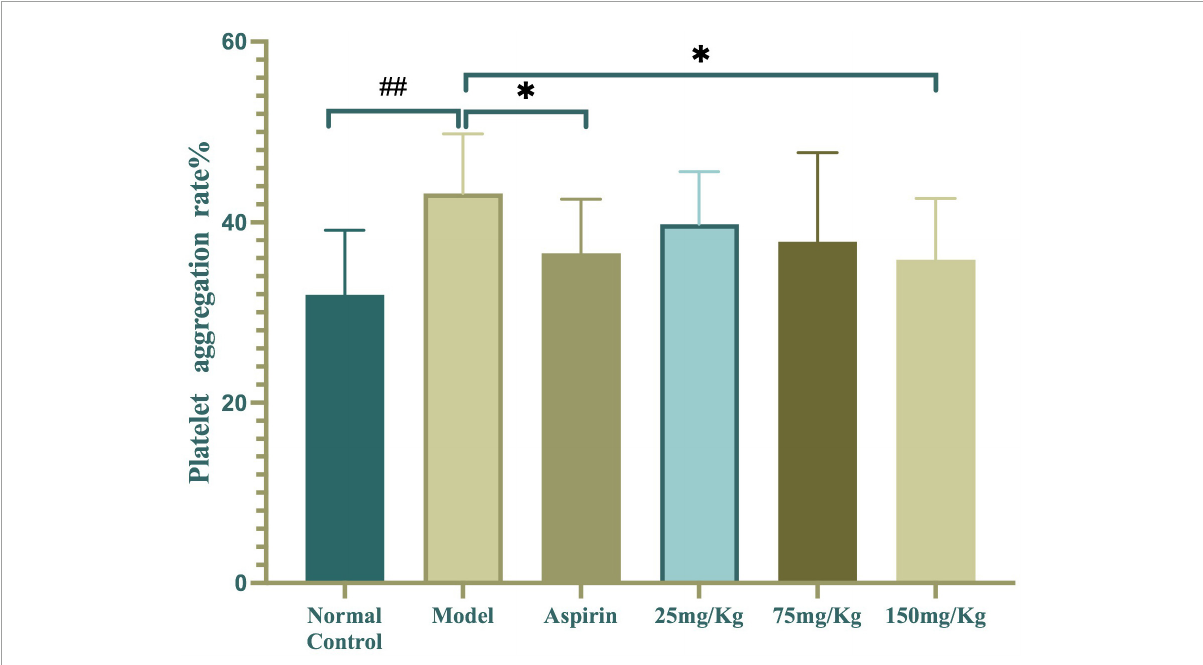
FIGURE5 Effects of water-soluble tomato concentrate (WSTC) on platelet aggregation in the κ carrageenan-induced black tail model. Mean platelet aggregation rate in the normal control group, black tail model group, Aspirin group, WSTC 25 mg · kg − 1 group, WSTC 75 mg · kg − 1 group, and WSTC 150 mg · kg − 1 group. All groups recorded the maximal aggregation rate after the addition of ADP (2.5 µ M). ## P < 0.01 compared to normal group; ∗ P < 0.05, compared to model